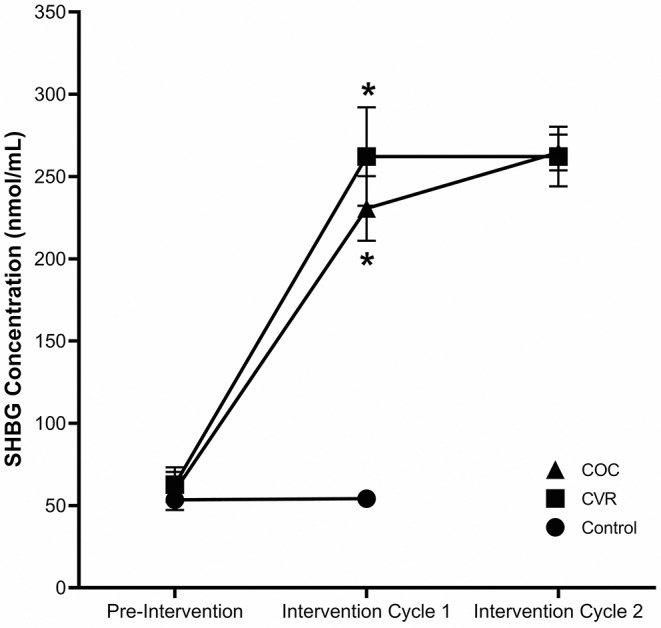
Compliance to study period and study group. SHBG concentrations for the COC (triangle), CVR (square), and control (circle), groups for pre-intervention, intervention cycle 1, and intervention cycle 2 compliance assessments. COC, combined oral contraception; CVR, contraceptive vaginal ring. * indicates difference from control group at same time point p < 0.05.